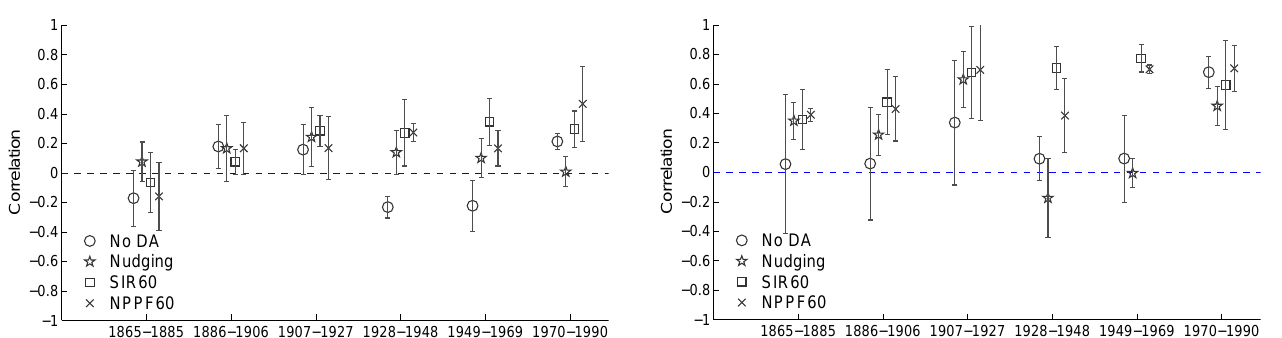
Fig. 10. Same as Figure 8, but for geopotential height.